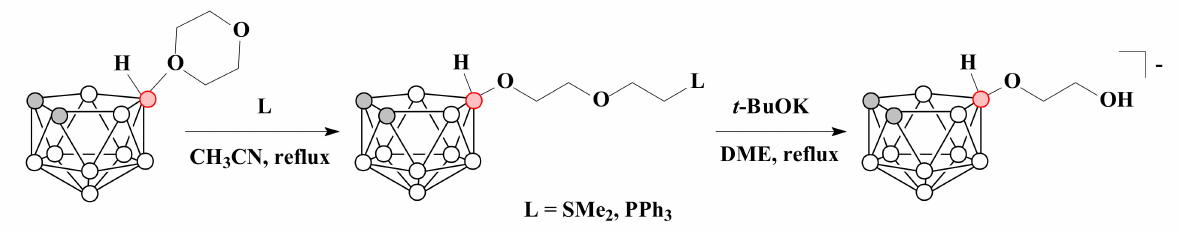
Scheme 20. The synthetic route to [10-HOCH 2 CH 2 O-7,8-C 2 B 9 H 11 ] − through the contraction of disclosed 1,4-dioxane ring.